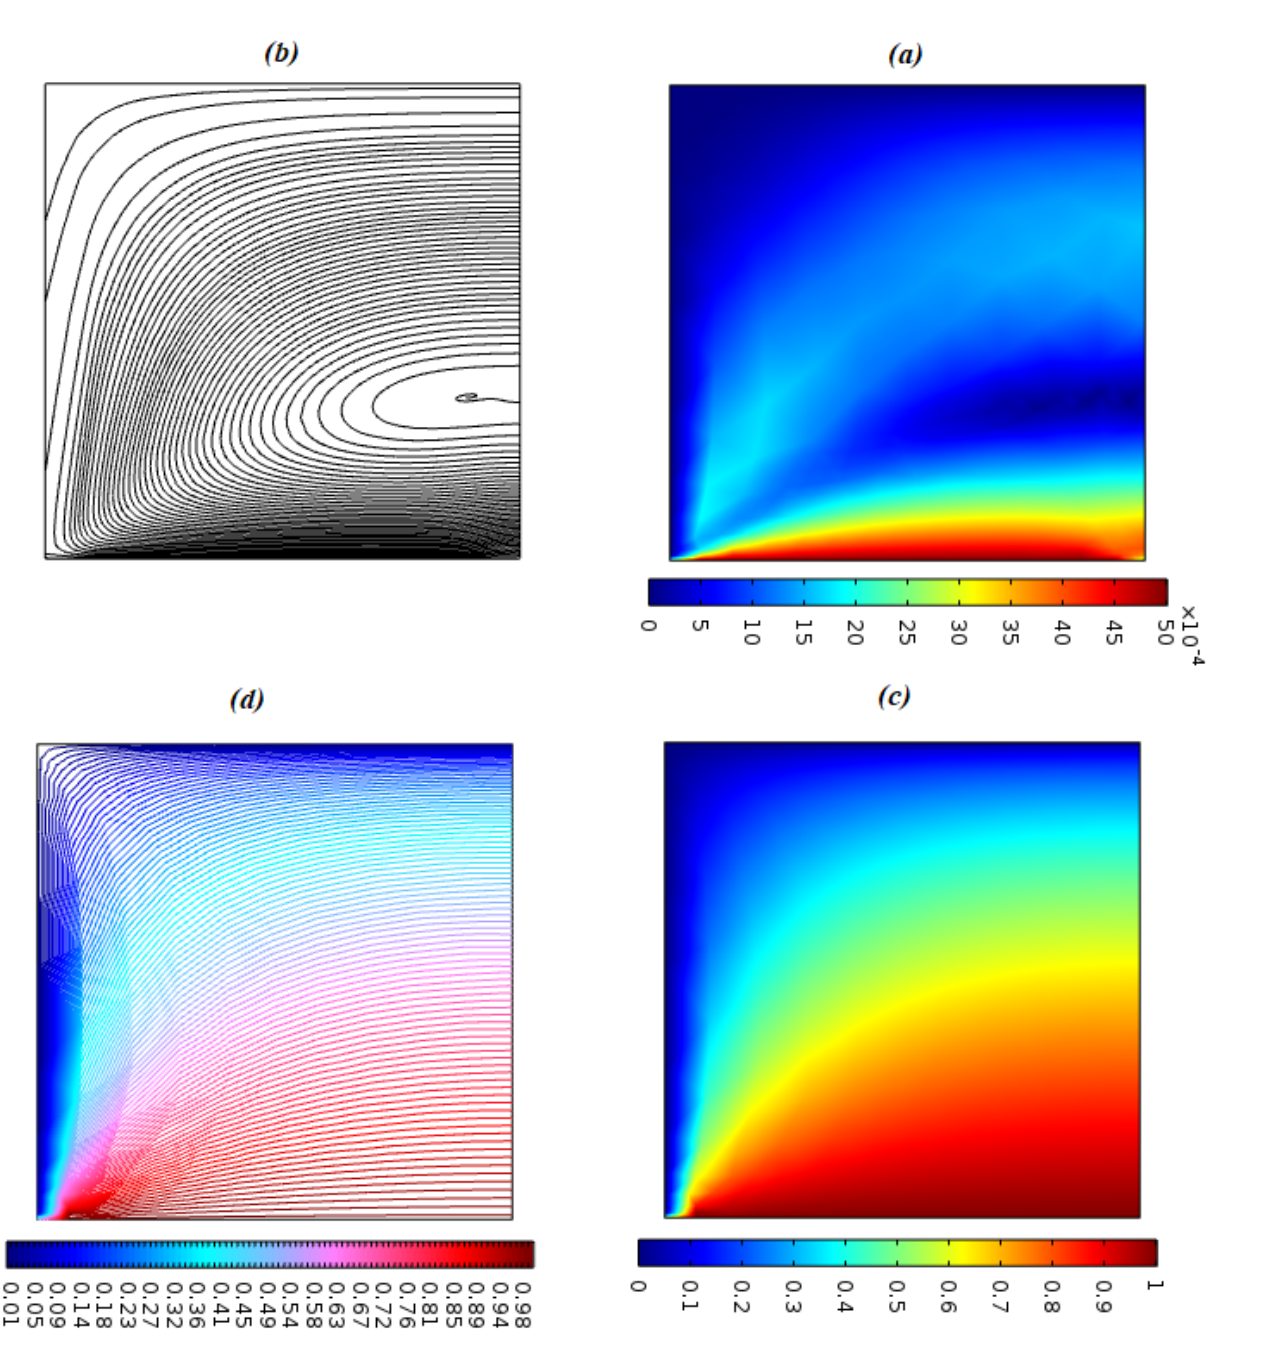
Figure 8. ( a ) Surface plot for velocity, ( b ) streamlines, ( c ) surface plot for temperature, ( d ) isothermal Figure 8. (𝐚) Surface plot for velocity, (𝐛) streamlines, (𝐜) surface plot for temperature, (𝐝) iso- contours using software with U w = 0.005, k ( T ) = 45 ( 1 + 30 T ) , β = 0.7, E 1 = 100, M = 0.5, E c = thermal contours using software with 𝑈 (cid:3050) = 0.005, 𝑘(𝑇) = 45(1 + 30𝑇), 𝛽 = 0.7, 𝐸 (cid:2869) = 100, 𝑀 = 0.5, 𝐸 = 0.7 . (cid:3030)